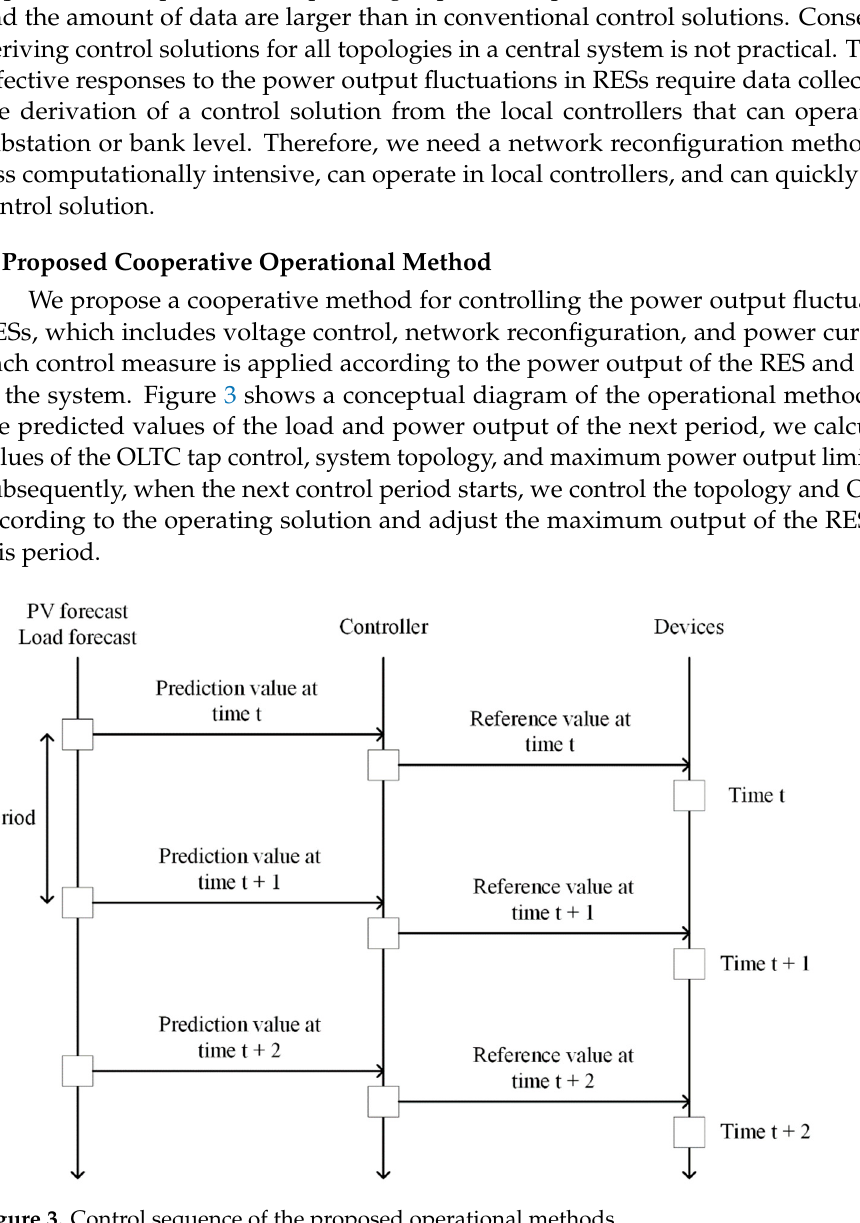
Figure 3. Control sequence of the proposed operational methods.